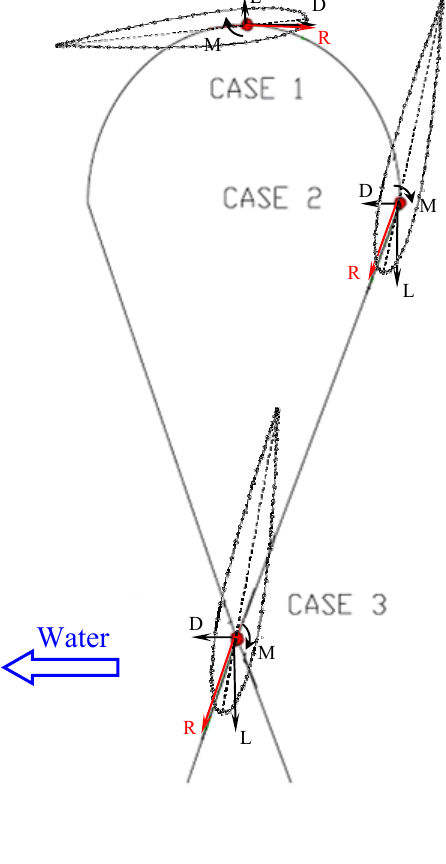
Figure 3. Body diagram of the hydrodynamic profile located at the most unfavorable situations through the eight path (M moment, L lift, D drag, R